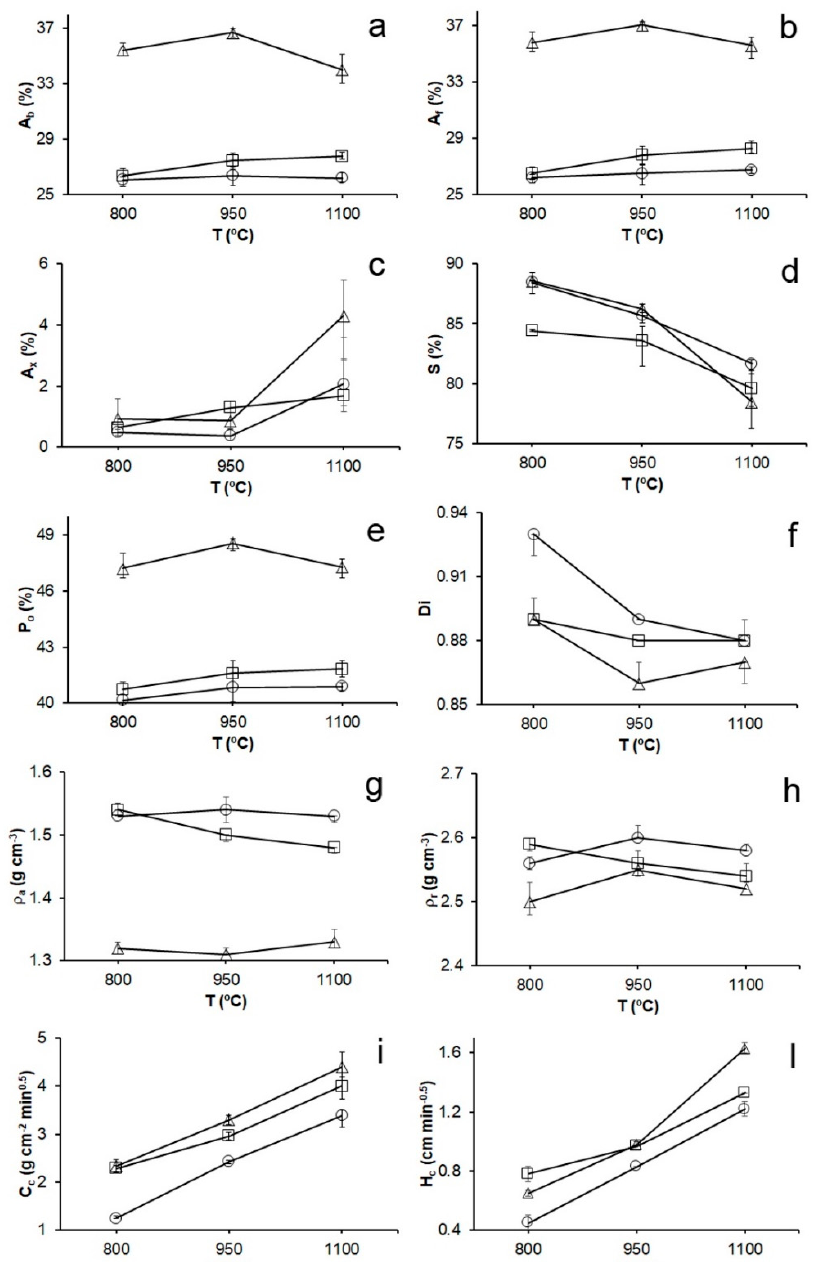
Figure 7. Hygric parameters of brick samples made without additives (open circle), with added sodium chloride (open square) and with added calcined diatomite sludge (open triangle) fired at 800, 950 and 1100 ◦ C. ( a ) Water absorption at atmospheric pressure ( A b , in %); ( b ) water absorption under vacuum ( A f , in %); ( c ) saturation coefficient ( S , in %); ( d ) degree of pore interconnection ( A x ); ( e ) drying index ( Di ); ( f ) open porosity ( P o , in %); ( g ) apparent density ( ρ a , in g cm − 3 ); ( h ) real density ( ρ r , in g · cm − 3 ); ( i ) capillarity coefficient ( C c , in g · cm − 2 min 0.5 ); ( l ) capillarity height ( H c , in cm · min − 0.5 ). Error bars indicate maximum and minimum values.